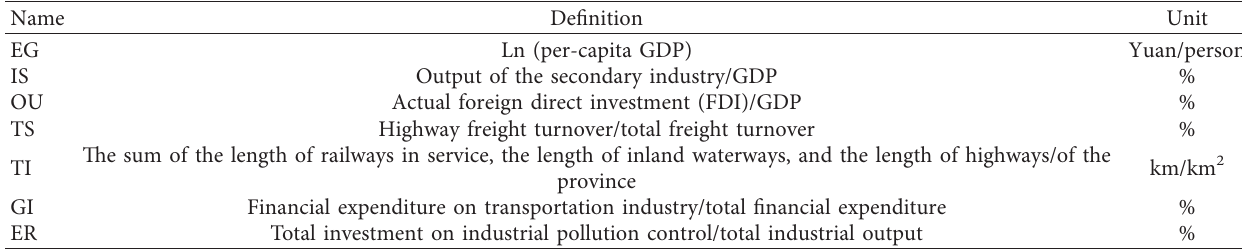
Table 2: Meaning of each influencing